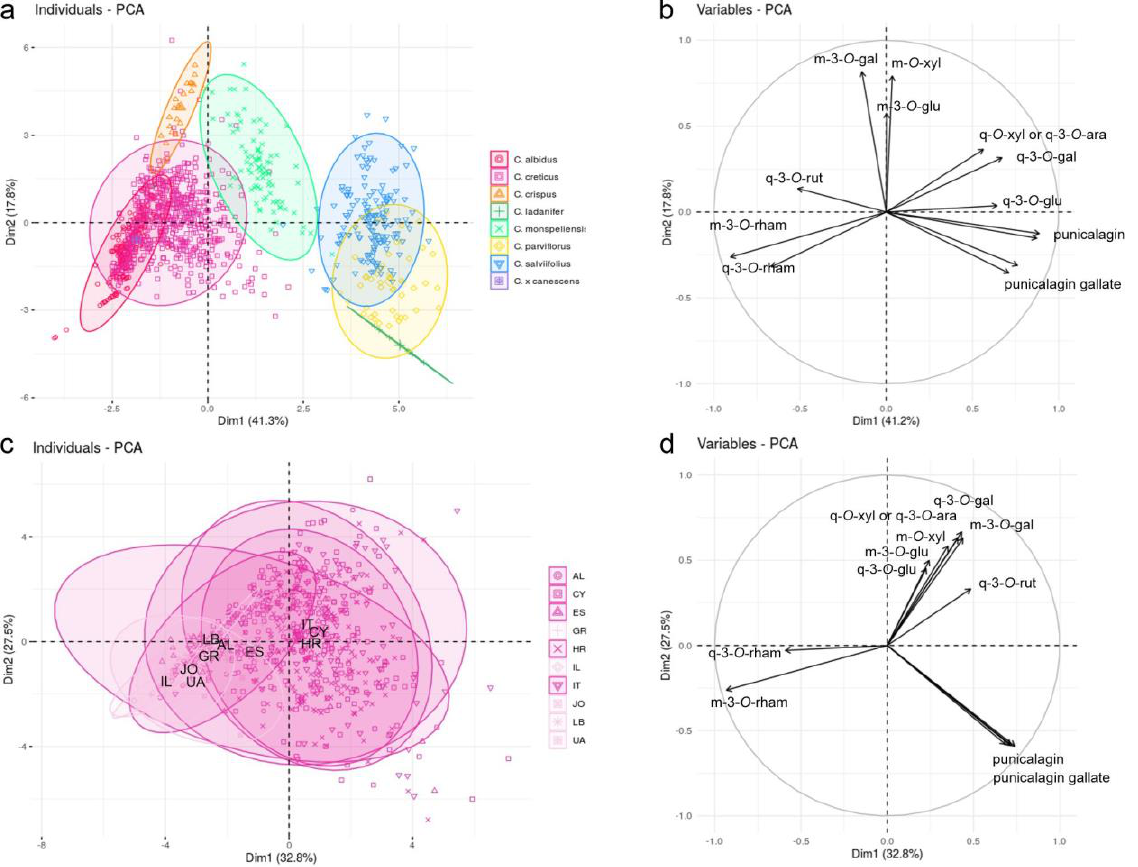
Figure 2. Principal component analysis (PCA) and corresponding factor loadings. ( a ) Plot of the first two dimensions (dim) from PCA performed over all seven species and the eleven evaluated compounds (relative area percent). In ( b ), the influence of each included variable is indicated. ( c ) Plot of first and second principal components from PCA performed over all sampled C. creticus populations (countrywise combined, group midpoints were accentuated) and the eleven main compounds used for quantification (relative area percent). ( d ) Factor loadings of the thirteen variables included. The percentage of variance explained by each dimension is indicated in parenthesis. Colors indicate either species affiliation (2a) or differentiate wild (pink) and cultivated (light pink) populations (2c). ES = Spain (three populations), IT = Italy (two cultivated populations and eleven natural populations), HR = Croatia (16 populations), AL = Albania (four populations), GR = Greece (four populations), UA = Ukraine (one population), CY = Cyprus (28 populations), LB = Lebanon (one population), IL = Israel (one population), JO = Jordan (one